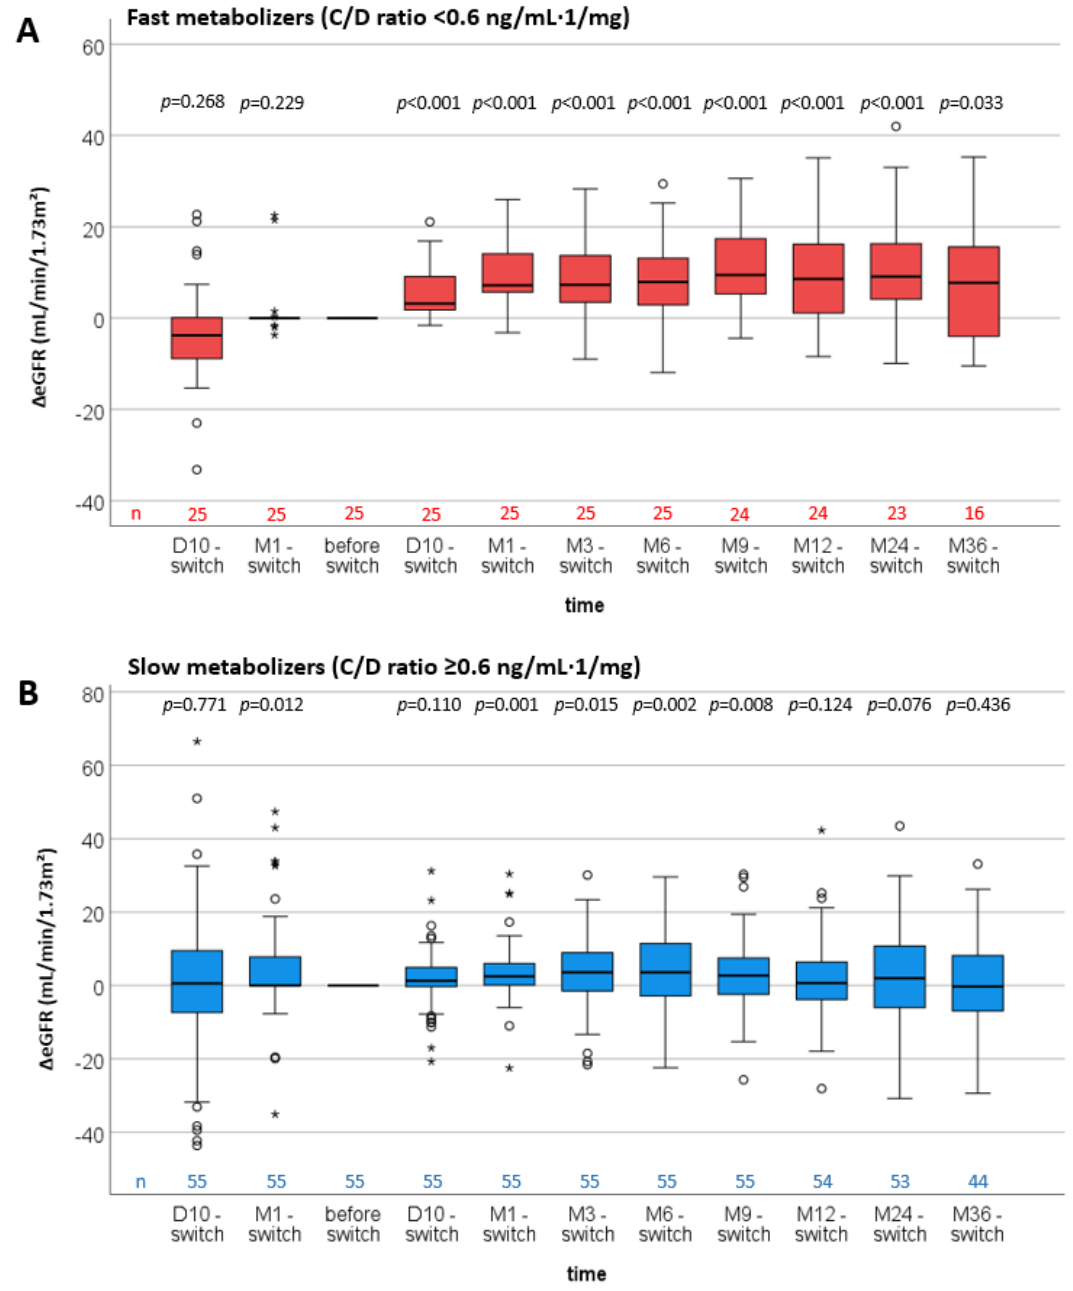
Figure 4. Boxplots of the differences in estimated glomerular filtration rates ( ∆ eGFR) of fast and slow Tac metabolizers (all time points—date of the switch). p -values are from Wilcoxon-signed rank tests for the dependent comparisons of eGFR values at each time point with the eGRF values at the time of the switch. The C/D ratio cut-off that characterized the metabolizer groups was changed to 0.6 ng/mL · 1/mg. In this case, fast metabolizers developed an even more pronounced increase in ∆ eGFR at D10 after conversion and all following time points compared with fast metabolizers defined by a C/D ratio cut-off of 1.05 ng/mL · 1/mg ( A ). ∆ eGFR of slow metabolizers also increased at M1–M9 after conversion to LCPT ( B